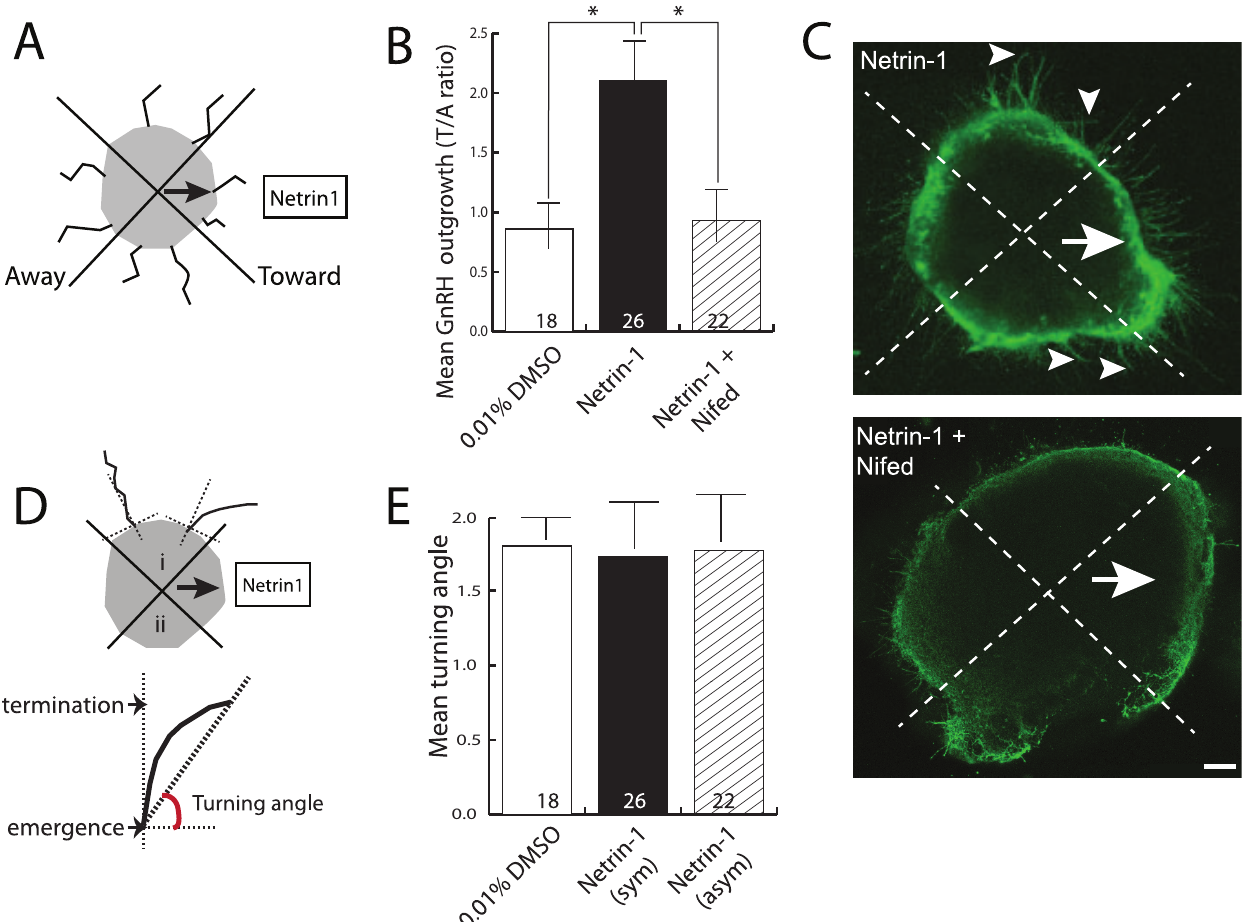
Figure 5. Netrin-1 does not chemoattract GnRH neurites. (A) Schematic diagram showing the fixed source with explant set-up and definition of toward and away sides. (B) Bar graph showing the toward:away (T/A) ratio of the lengths of GnRH neurites (y-axis) as a function of treatment (x- axis). Numbers at the base of each bar indicate the number of explants used, and are from fetal brains derived from 3 independent pregnancies. Error bars indicate SEM. *, P , 0.05 with Mann-Whitney test of significance. (C) Example of explants cultured for 2 DIV in the presence of a fixed source of Netrin-1, either with (lower panel) and without (upper, control) nifedipine, and immunostained to reveal GnRH neurons and their processes. The arrow indicates the toward side (ie., the direction of the Netrin-1 source), and arrowheads indicate representative GnRH + neurites. Scale bar, 40 m m. (D) Schematic drawing of turning angle analysis. Upper indicates two possible orientations in which neurites may grow as they exit the explant, either growing relatively straight (left) or turning toward the Netrin-1 source (right). i and ii indicate the two quadrants from which neurites were counted. Lower indicates how turning angle was measured, where emergence refers to the point at which the neurite exits the explant (set to 0), and termination indicates the position of the terminal swelling that demarcates the end of the neurite. (E) Bar graph showing the mean turning angle (y- axis) of GnRH neurites extending from the explant across the conditions indicated (x-axis). Error bars represent SEM. Numbers at the base of each bar indicate the number of explants used, and are from fetal brains derived from 3 independent pregnancies. Abbreviations, Netrin-1 (sym) indicates explants that were exposed to a symmetrical Netrin-1, Netrin-1 (asym) indicates explants that were exposed to asymmetrical Netrin-1 from a fixed